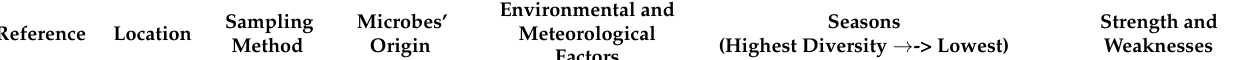
Table 2. Parameters that affect the microbial community: microorganisms’ emission sources, environmental and meteorological factors, and the season in which the alpha diversity was higher reported by each selected paper. Strength (indicated with ) and criticalities ( ) for each paper are reported.